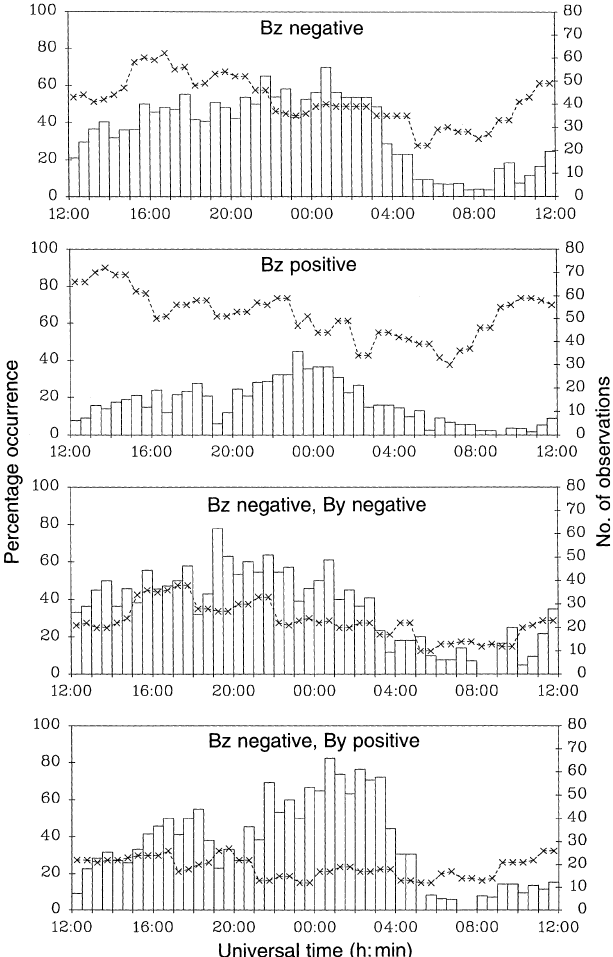
Fig. 6. Variation of the diurnal distribution of ion frictional heating with the orientation of the y and z components of the interplanetary magnetic field. The form of each panel is the same as that of